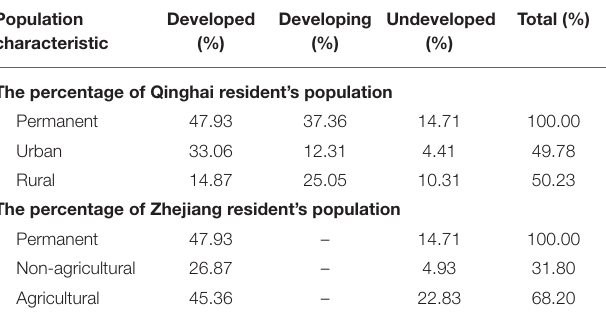
TABLE 2 | The percentage of population characteristic of sampling sites. Population characteristic